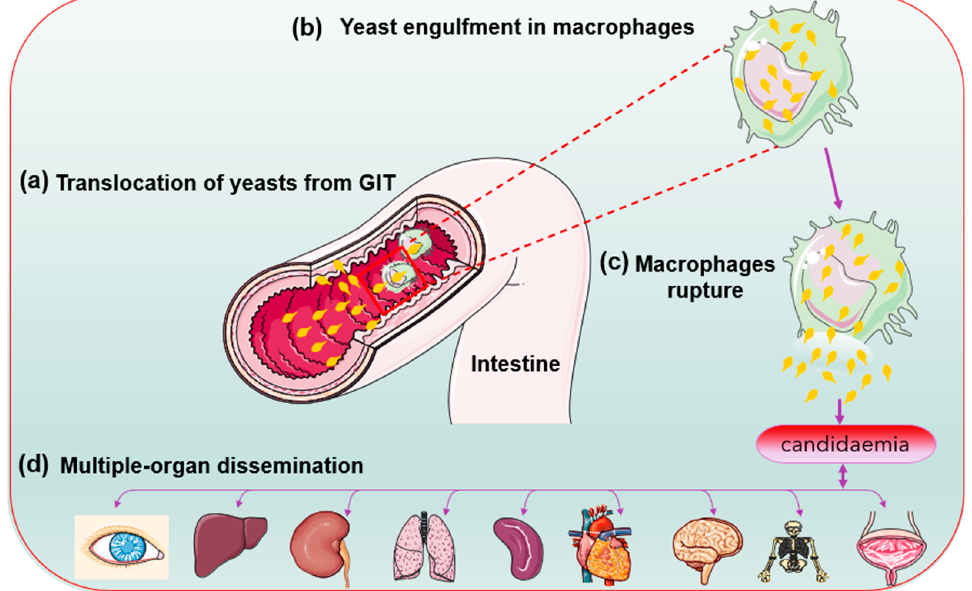
Figure 3. Candida glabrata cells (yellow) replication inside the macrophage cells before organ